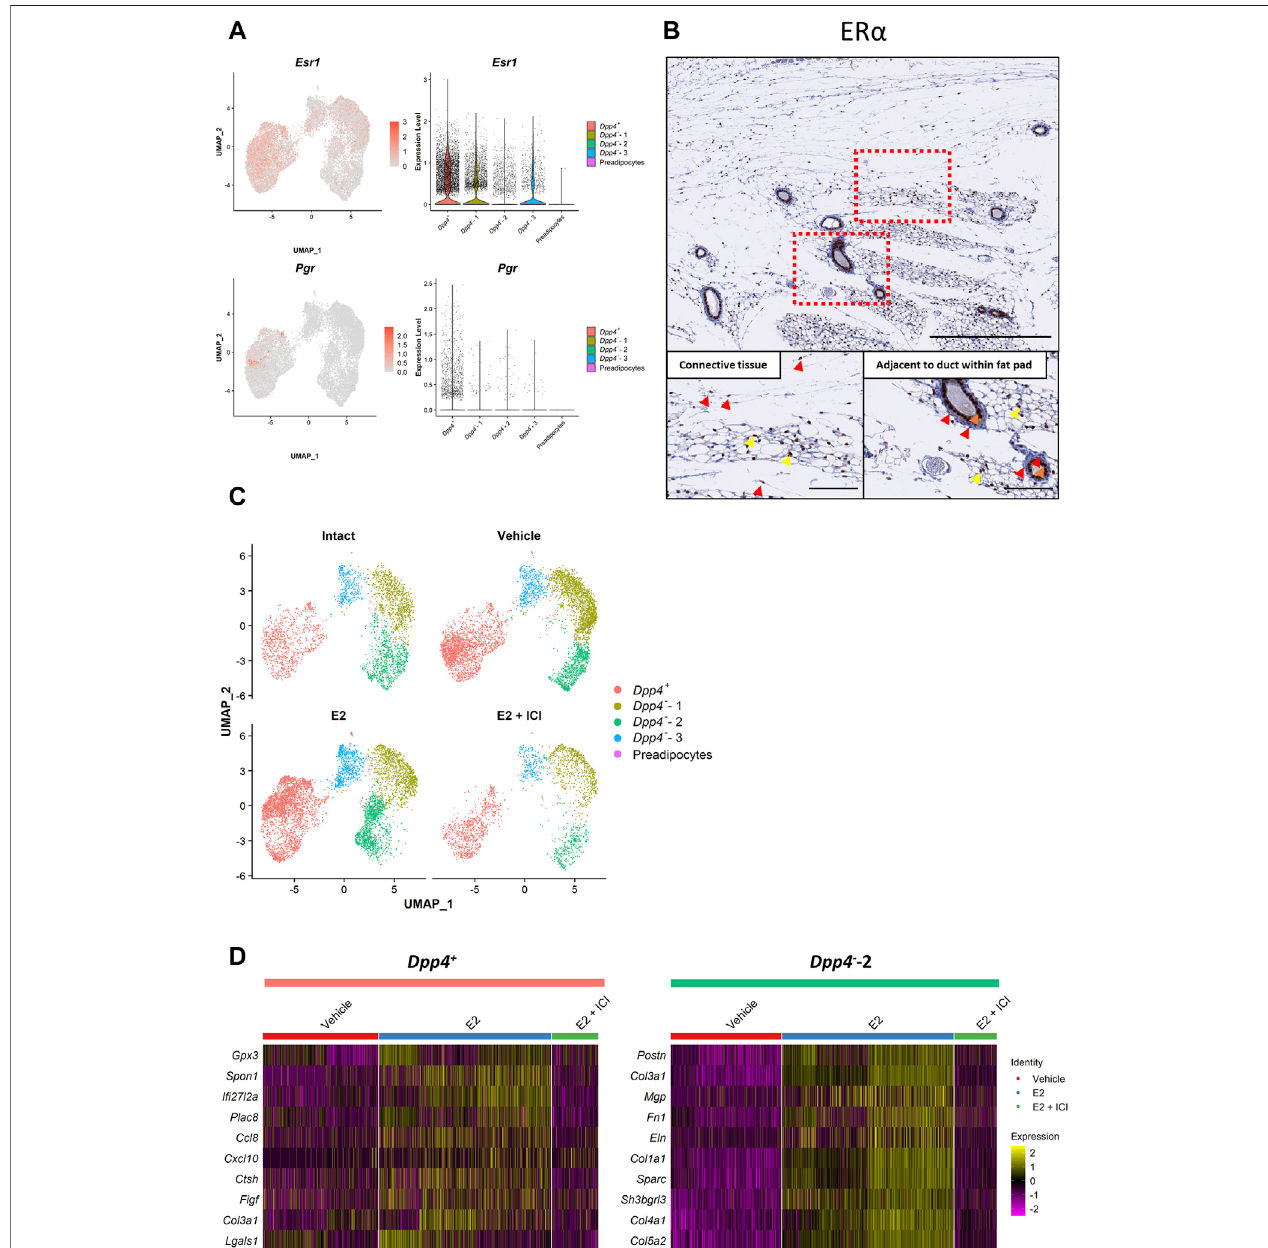
FIGURE 4 | Estrogen treatment affects the gene expression pro fi les of the Dpp4 + and Dpp4 - -2 fi broblasts in an indirect and population-speci fi c manner. (A) The expressionoftheovarianhormonereceptors( Esr1 and Pgr ). Esr2 expressionwasnotdetectedinthedataset.Eachfeatureplotontheleftpanelshowsthedistributionof the marker-expressing cells with color indicating the expression level. Each violin plot on the right panel shows the expression level of each gene in each cluster. (B) The immunohistochemicalstainingforER α inthenormalmousemammarygland.Themammaryglandsofeight-week-oldC57BL/6Jmicewerecollectedtogetherwith skin (atthetop partoftheimages)and cross-sectioned.Theupper panelsshow theentireimages ofthemammaryglands at lowmagni fi cations. Thelowerpanels show the magni fi ed images of the boxed area for the connective tissue region around/within the mammary fat pad (left) and the region adjacent to the mammary gland ducts within the fat pad (right). Red arrowheads indicate the representative staining pattern of each fi broblast type. Yellow arrowheads indicate the positive staining in the cells amongthe adipose tissue. Orange arrowheadsindicate thepositivestainingin themammaryluminal epithelialcells. Scale bar =500 μ m(upper) and 100 μ m(lower). (C) The UMAP plot for the cells from each treatment group. “ Intact ” (top left) and “ E2 + ICI ” (bottom right) includes the cells from the intact (Intact) and E2+ICI group (VCD_E2_ICI)oftheVCDmodel,respectively. “ Vehicle ” (topright)includesthecellsfromthevehiclegroupsoftheOVXandVCDmodels(OVX_vehicleandVCD_vehicle). “ E2 ” (bottom left) includes the cells from the E2 and E2+P4 groups of the OVX and VCD models (OVX_E2, OVX_E2_P4, VCD_E2 and VCD_E2_P4). Each cell is representedbyeachdotandiscoloredaccordingtotheclusters. (D) Theheatmapofthetop10most-upregulatedgenesintheE2-treatedcellscomparedtothevehicle- treated cells in the Dpp4 + and Dpp4 - -2 fi broblasts. Each column represents each cell and each row represents each gene. Log-normalized gene count was scaled per gene. Color bar at the top indicates the cell types ( Dpp4 + fi broblasts, pink; Dpp4 - -2 fi broblasts, green) and treatment groups (vehicle, red; E2, blue; E2 + ICI, green).